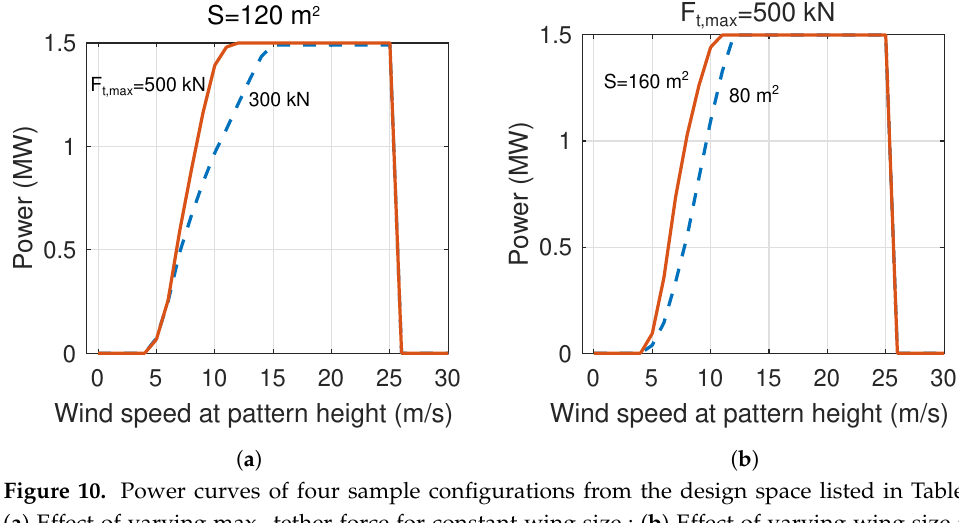
Figure 10. Power curves of four sample configurations from the design space listed in Table 2. ( a ) Effect of varying max. tether force for constant wing size.; ( b ) Effect of varying wing size for constant max. tether